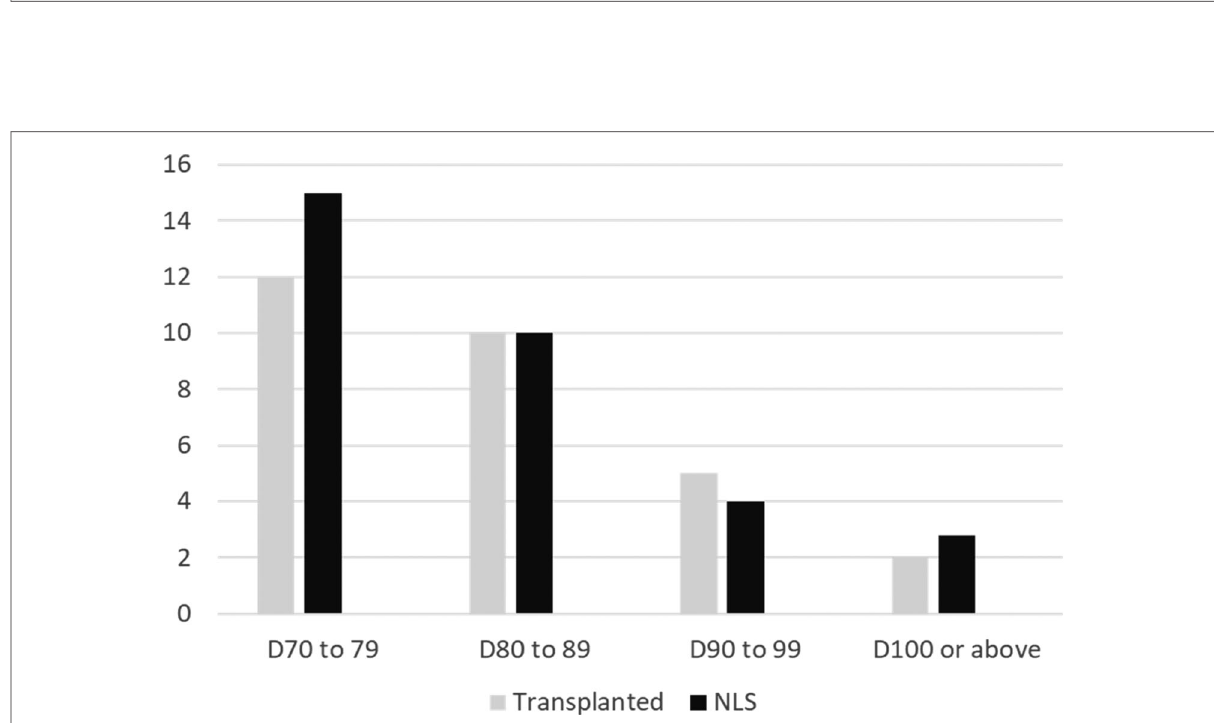
FIGURE 1 Kaplan Meier analysis revealed approximately 50% of patients with KPE after day 70 of life could achieve long term native liver survival.